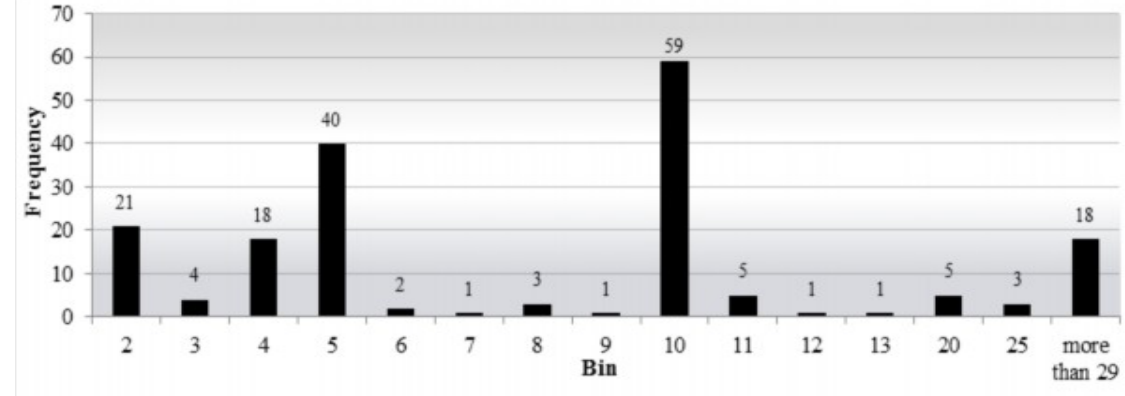
Fig. 3. Number of stock splits according to swap rate (Histogram)